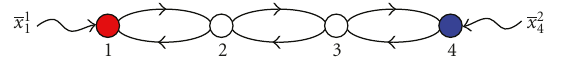
Figure 4: Tandem wireless network with N = 4 nodes and S = 2 commodities. Di ff erent commodities are represented by di ff erent